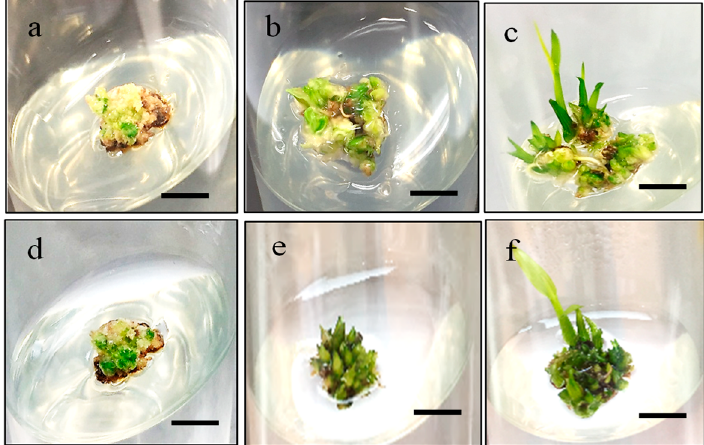
Figure 9. The development of MR220 ( a – c ) and MR220-CL2 ( d – e ) calli cultured on MS regeneration media supplemented with 0.5 mg / L naphthalene acetic acid (NAA), 2 mg / L kinetin and 1 mg / L benzyl-amino-purine (BAP), from ( a , d ) green somatic embryo with adventitious shoot stage, ( b , e ) shoot started to emerge and ( c , f ) shooting stage (Bar = 1 cm).